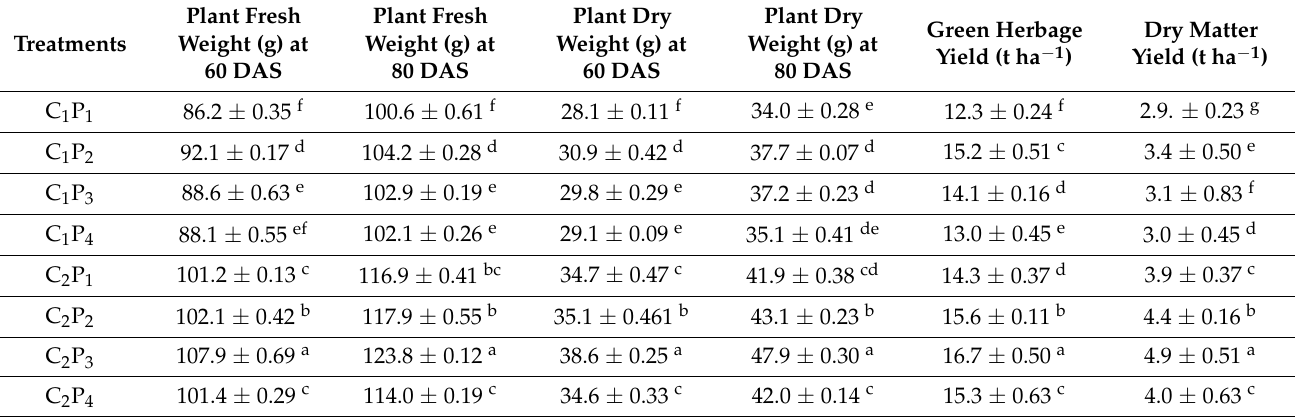
Table 2. Fresh and dry weight per plant, green herbage yield and dry matter yield under the interactive effect of genetic divergence and row configuration in a temperate